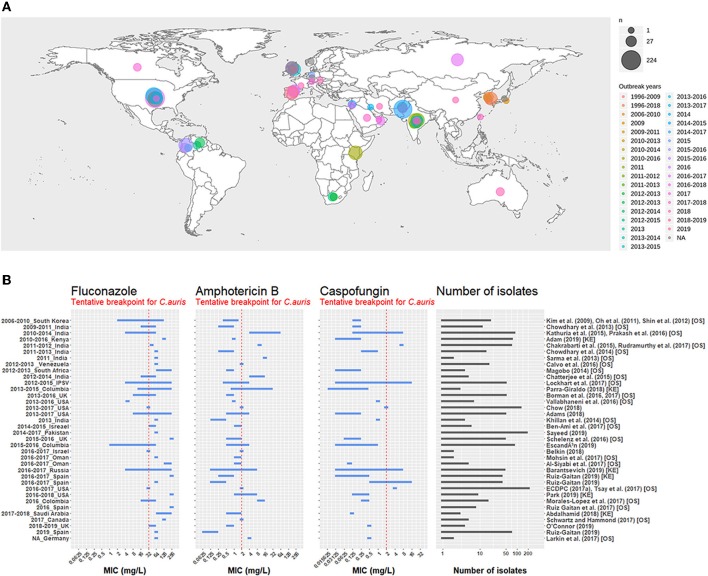
(A) Map representing the number of isolates per outbreak since 1996. The first outbreak year is brown-colored and the latest outbreak year is in pink. Circle size is proportional to the number of isolates reported for each outbreak. Outbreak survey was performed recovering data from three main reviews (Osei Sekyere, 2018; Jackson et al., 2019; Kenters et al., 2019) and complemented by a pubmed search using the query “Candida” AND “auris” AND “outbreak” as keywords. Results were limited in time, between the 21/07/2017, the latest study in the systematic review by Osei Sekyere and the 31/08/2019, when the literature search was performed. Studies not present in the review by Osei Sekyere: (Biswal et al., 2017; Abdalhamid et al., 2018; Adams et al., 2018; Belkin et al., 2018; Chow et al., 2018; Desoubeaux et al., 2018; Lesho et al., 2018; Mayor, 2018; Parra-Giraldo et al., 2018; Ruiz-Gaitán et al., 2018, 2019a,b; Sexton et al., 2018; Adam et al., 2019; Barantsevich et al., 2019; Escandón et al., 2019; Leach et al., 2019; O'Connor et al., 2019; Park et al., 2019; Sana et al., 2019; Sayeed et al., 2019). (B) MIC ranges for three antifungals measured in C. auris isolates from different outbreaks around the world. The red dotted line represents the tentative breakpoint proposed by the CDC. IPSV is an acronym for “India, Pakistan, South Africa, and Venezuela,” as strains from these countries were all analyzed in the same study. Outbreak survey was performed identically to (A). Only outbreak with >1 isolate were plotted. Studies cited by Osei Sekyere are signaled with [OS] and studies cited by Kenters et al. with [KE].